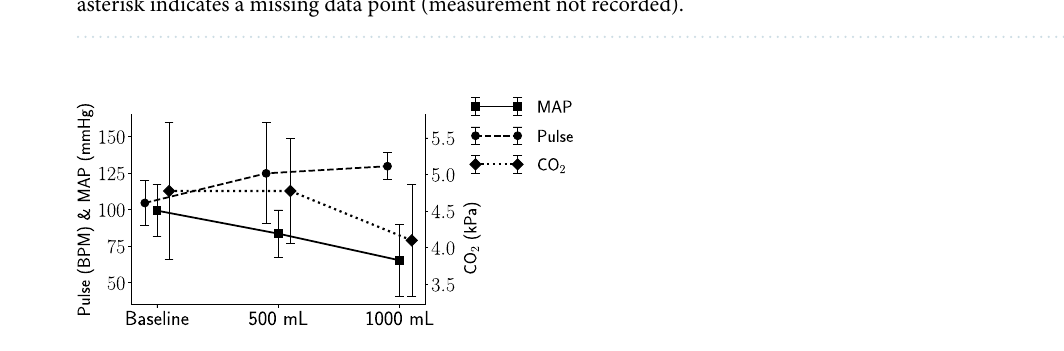
Figure 2. Vital signs at baseline, 500 mL and 1000 mL hemoperitoneum. The left y-axis indicates pulse rate and mean arterial pressure (MAP) levels and the right y-axis end tidal carbon dioxide ( CO 2 ) levels. The whiskers show the standard